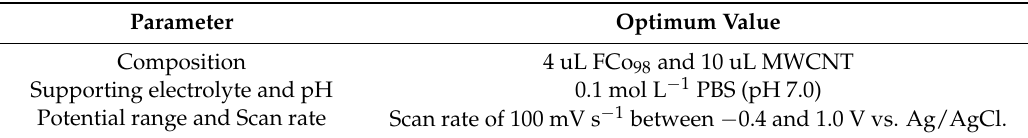
Table 2. Optimized cyclic voltammetry parameters for noradrenaline determination using the modified glassy carbon electrode with cobalt ferrite and carbon